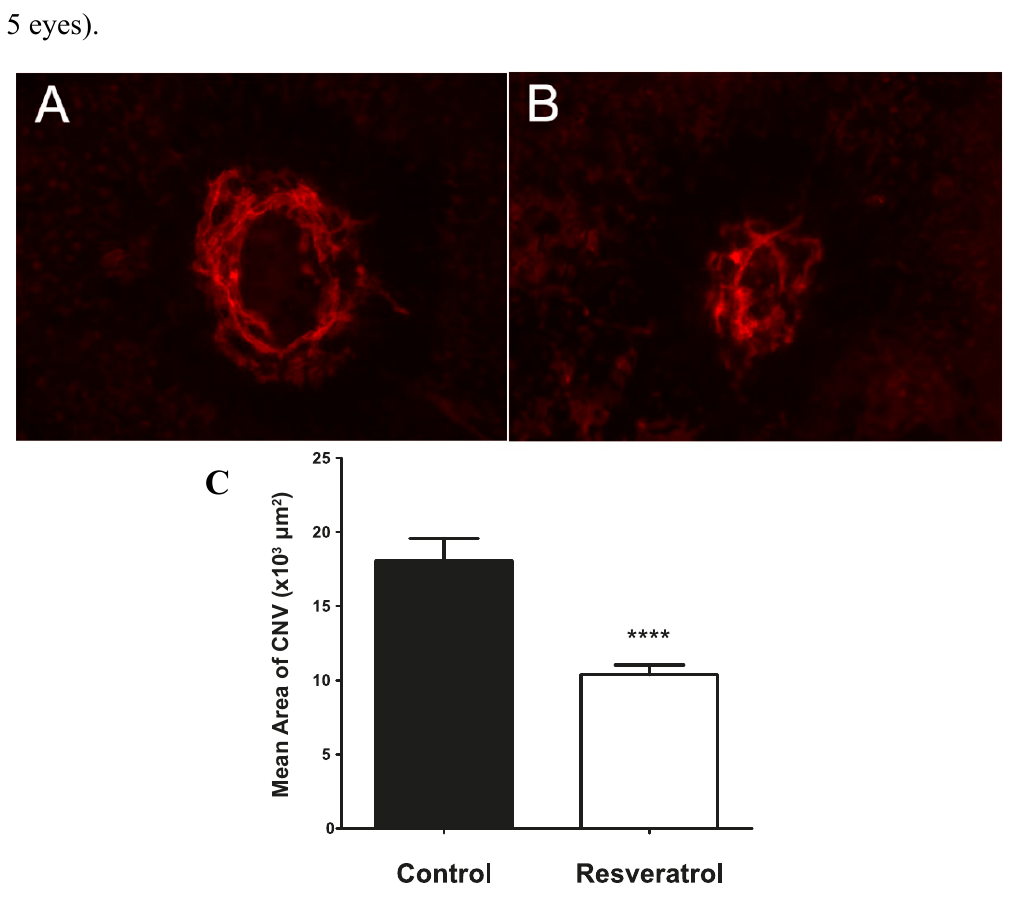
Figure 1. Resveratrol reduces blood vessel formation in a mouse model of CNV. Representative sclerochoroidal flat mounts after staining with intercellular adhesion molecule-2 antibodies; CNV in mice that received vehicle ( A ) or resveratrol ( B ) in their a total of 16 days. ( C ) Quantification of the data ( **** p value resveratrol =